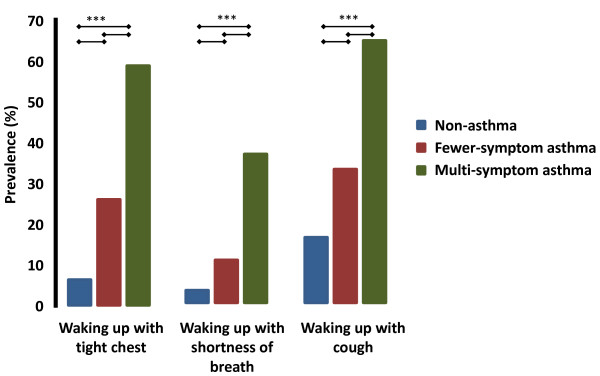
Prevalence of waking up with tight chest, shortness of breath or cough, during the last 12 months, in the non-asthma, fewer-symptom asthma or multi-symptom asthma groups. Subjects with multi-symptom asthma had a higher risk of waking up at night regardless of which respiratory symptom is analyzed. Blue: non-asthma, maroon, fewer-symptom asthma and green: multi-symptom asthma. *** P < 0.001.